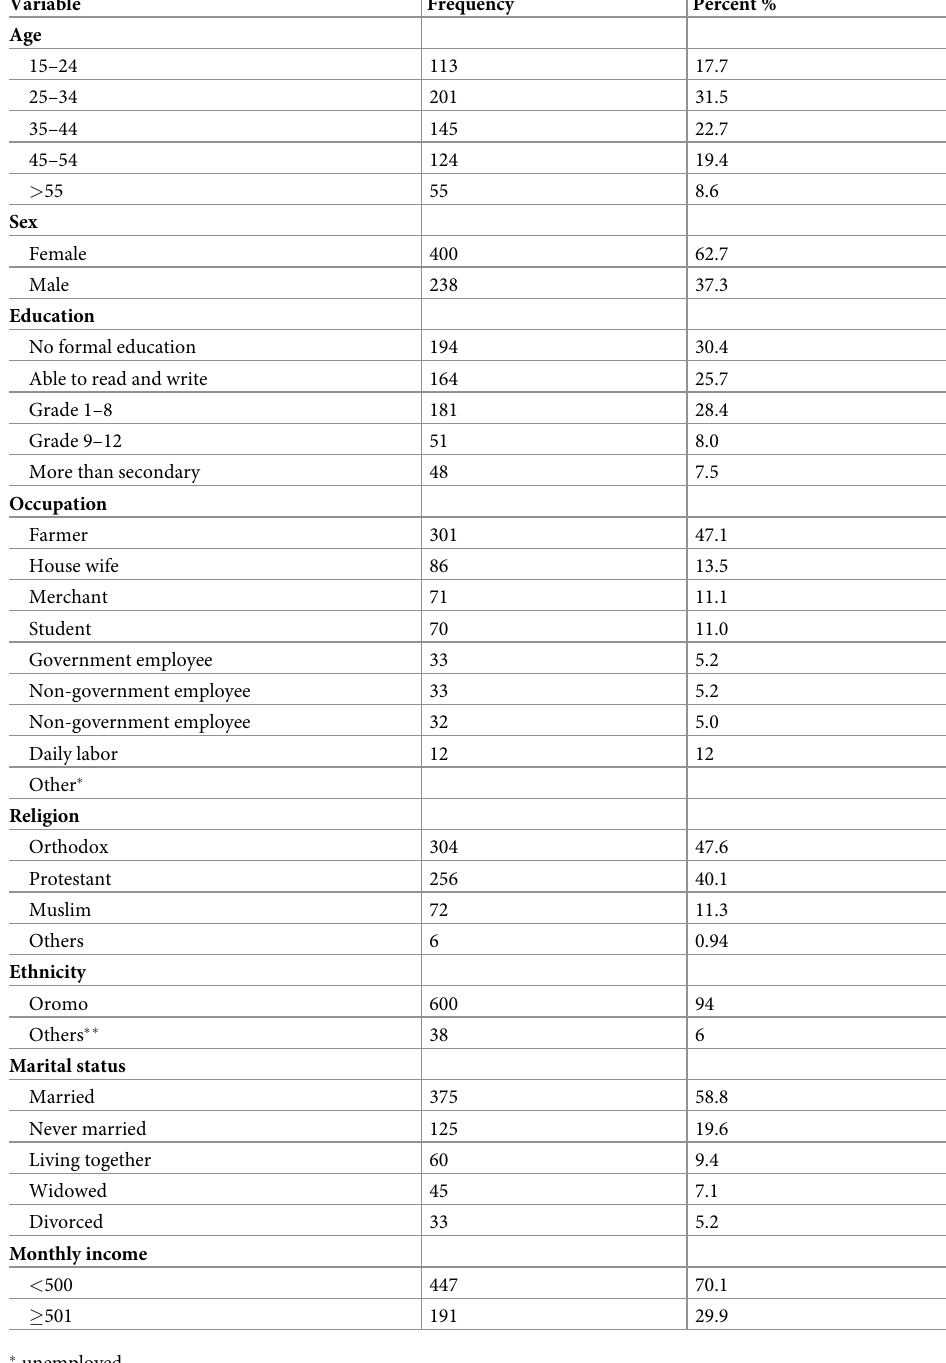
Table 1. Socio-demographic characteristic of study participants in Dano district, West shewa Zone, Oromia, Ethi- opia,